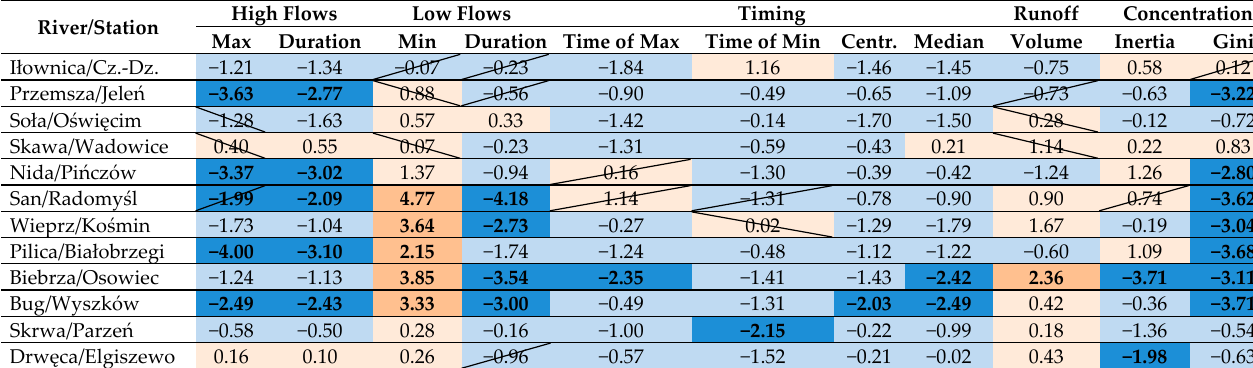
Table 7. Results of the Mann test ( uF statistics) for trends in the winter season daily flow characteristics at hydrological stations on the Vistula tributaries; orange colour denotes positive uF values, blue colour negative. The marks represent the diagonal lines from the upper left corner to the lower right to show that the value can decrease if autocorrelation is taken into account and the opposite is true for the cases when the autocorrelation causes an increase in the presented value. Numbers in bold indicate statistically significant changes at α level 0.05.